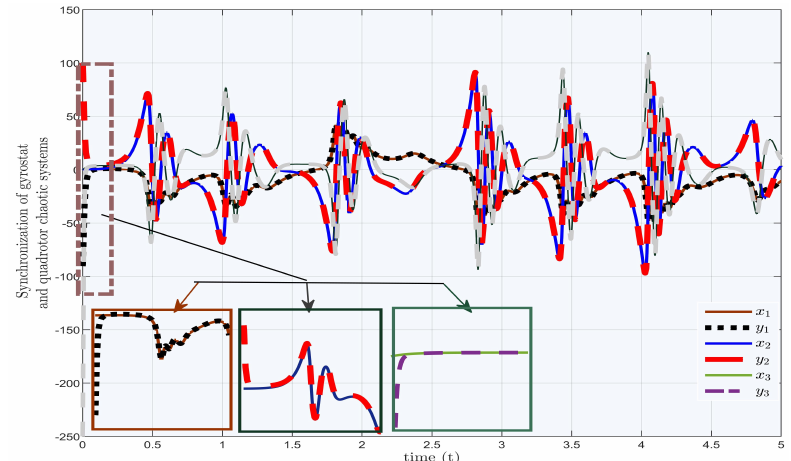
Figure 13. Synchronization of master and slave systems.